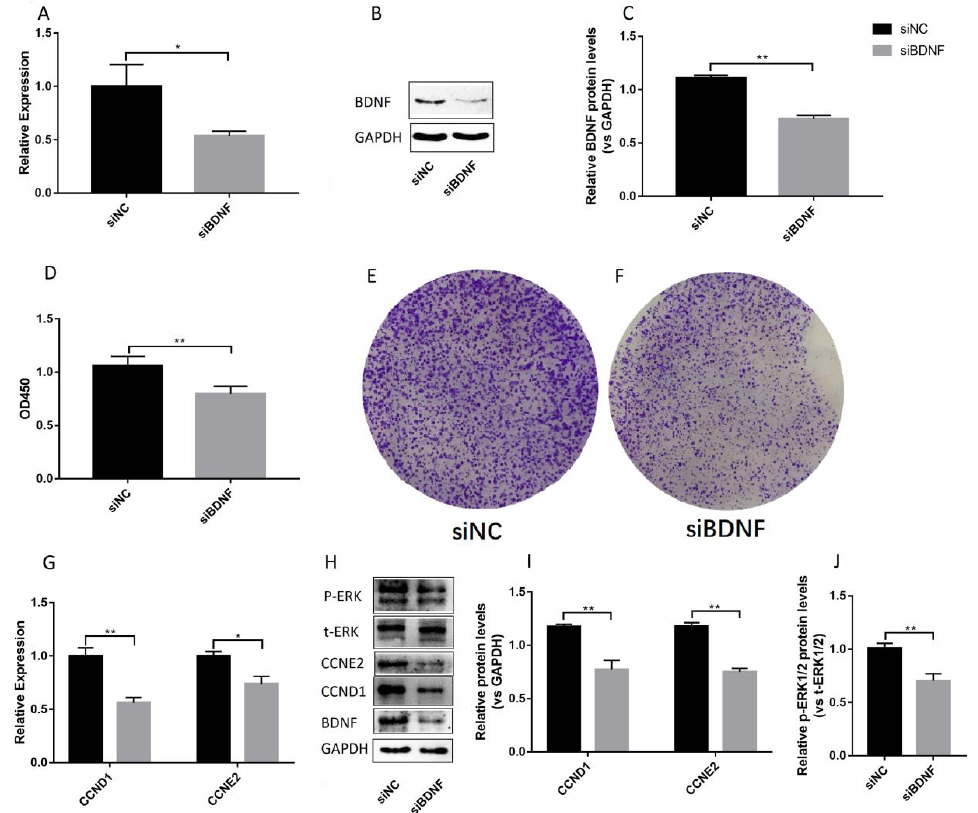
Figure 4. The e ff ect of siBDNF on the proliferation of Ishikawa cells. The Ishikawa cells were transfected with siNC (control) or siBDNF for 36 h. qRT-PCR and Western blot analysis were used in detecting the expression levels of BDNF mRNA ( A ) and protein ( B ). ( C ) Relative protein levels were analyzed by grey scanning. ( D ) Cell counting kit-8 analysis was performed for the detection of cell viability. ( E ) Colony formation assay was used in detecting the proliferation of cells treated with siNC. ( F ) Colony formation assay was used in detecting the proliferation of cells treated with siBDNF. ( G ) Relative mRNA expression levels of CCND1 and CCNE2 genes were detected by qRT-PCR. ( H ) Protein levels of CCND1 and CCNE2 genes, P-ERK, and t-ERK were detected by Western blot analysis. ( I ) Relative protein levels of CCND1 and CCNE2 genes were analyzed by grey scanning. The expression levels of mRNA and proteins were normalized by the GADPH gene, which plays an important role as an internal reference calibration for qRT-PCR and Western blot analysis. ( J ) Relative protein levels of P-ERK and t-ERK were analyzed by grey scanning. Statistical analysis is shown. * p < 0.05, ** p <